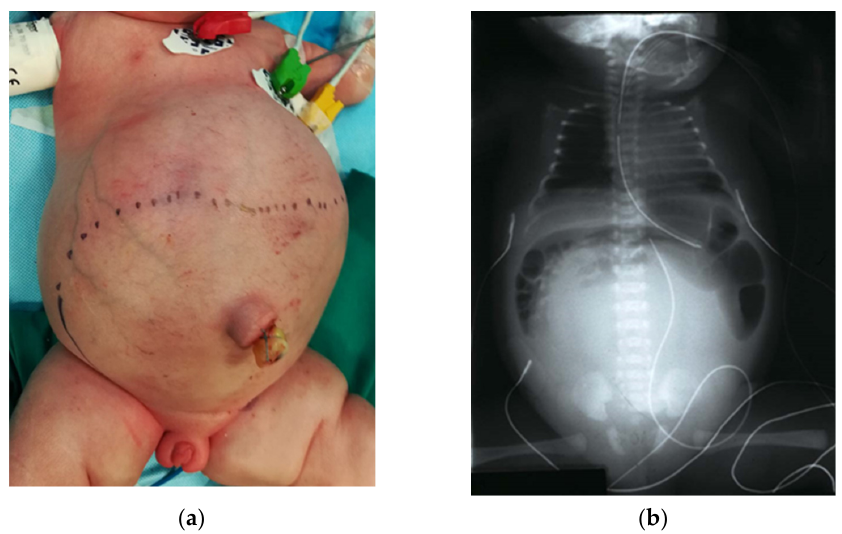
Figure 5. Hydrocolpos is found on: ( a ) a severely distended abdomen on physical examination at birth, and ( b ) a plain film radiograph showing a large opacifying structure with all bowel pushed superiorly, indicating a large pelvic mass.